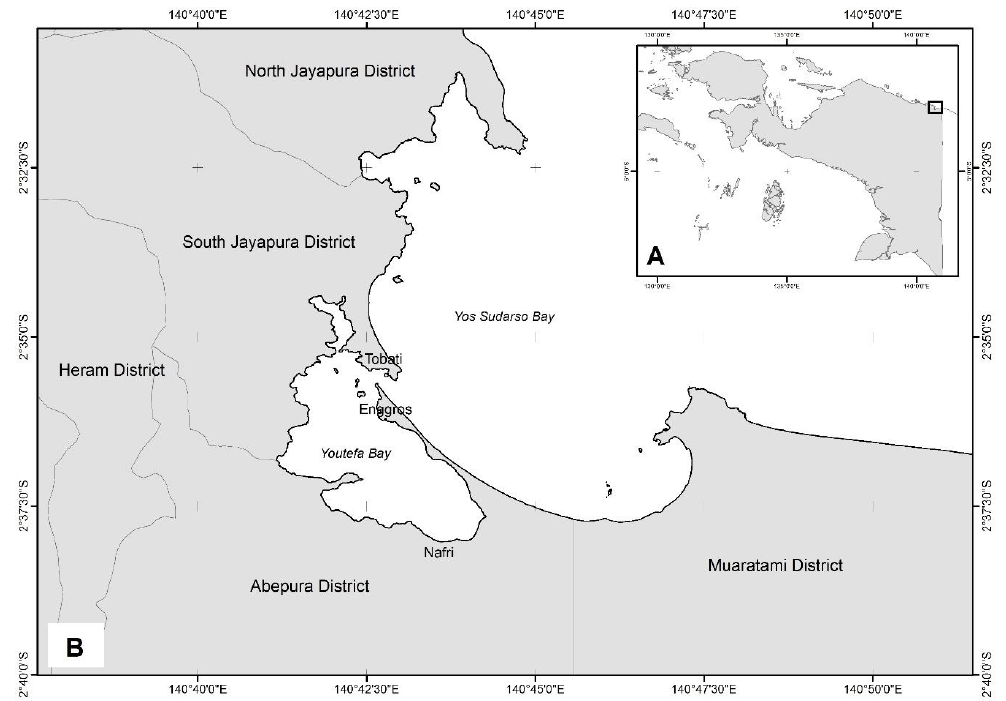
Fig. 1. Map of study site; (A) Papua Island, and (B) Jayapura City, Papua Province,